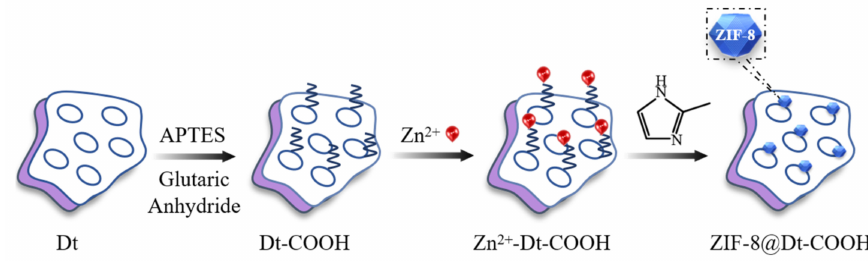
Figure 7. The fabrication flow-chart of